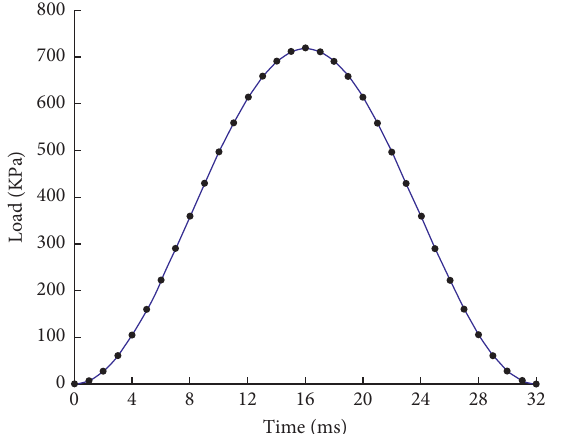
Figure 4: Comparison of pavement deflection calculation results at Figure 2: FWD load time history curve. different time. Table 1: Dynatest8000 FWD transducer